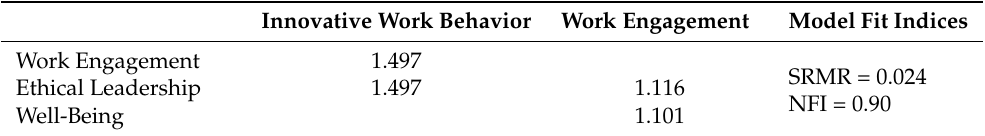
Table 4. Good fit model and VIF.